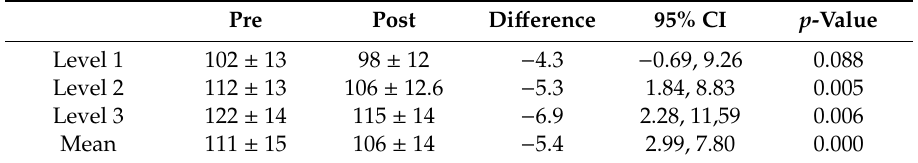
Table 4. Heart rate (HR) recorded during the final seconds of Level 1, 2 and 3, and Mean HR calculated from averaged individual HR values recorded during the final seconds of Level 1, 2 and 3 of the Chester Step test conducted pre- and post-dancing intervention (n = 21). Values are mean ± SD. Di ff erence